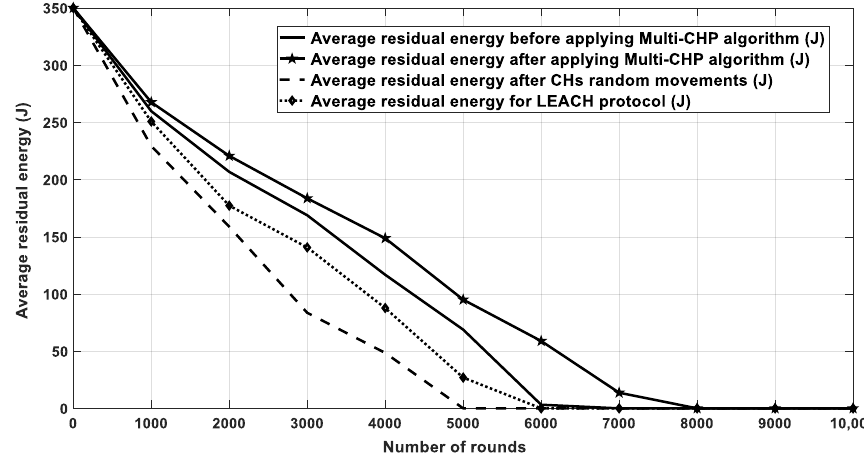
Figure 17. Residual energy for multi-CHP and other related work.